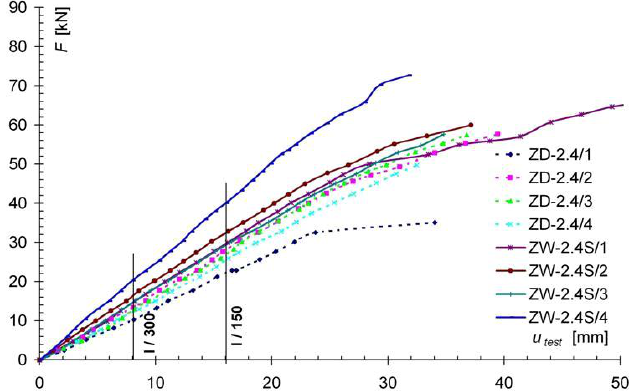
Figure 9. Comparison of results from the F-u test for the ZD-2.4 and ZW-2.4S series models.